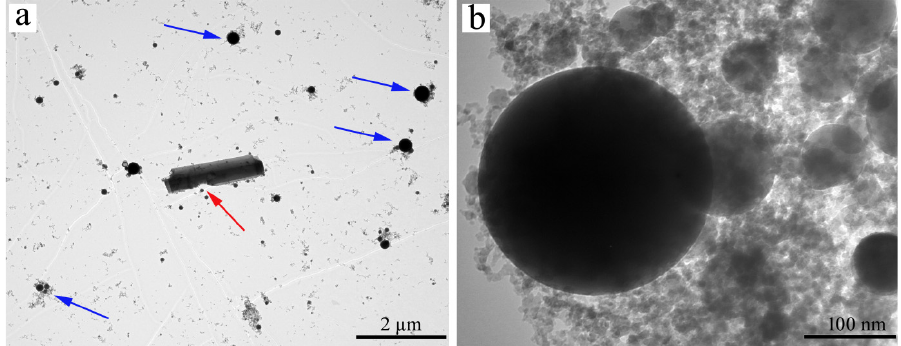
Figure 11. ( a ) Transmission electron micrographs of polypropylene filter residues indicated by blue arrow and talc indicated by red arrow; ( b ) spherical morphology of polypropylene filter residues.